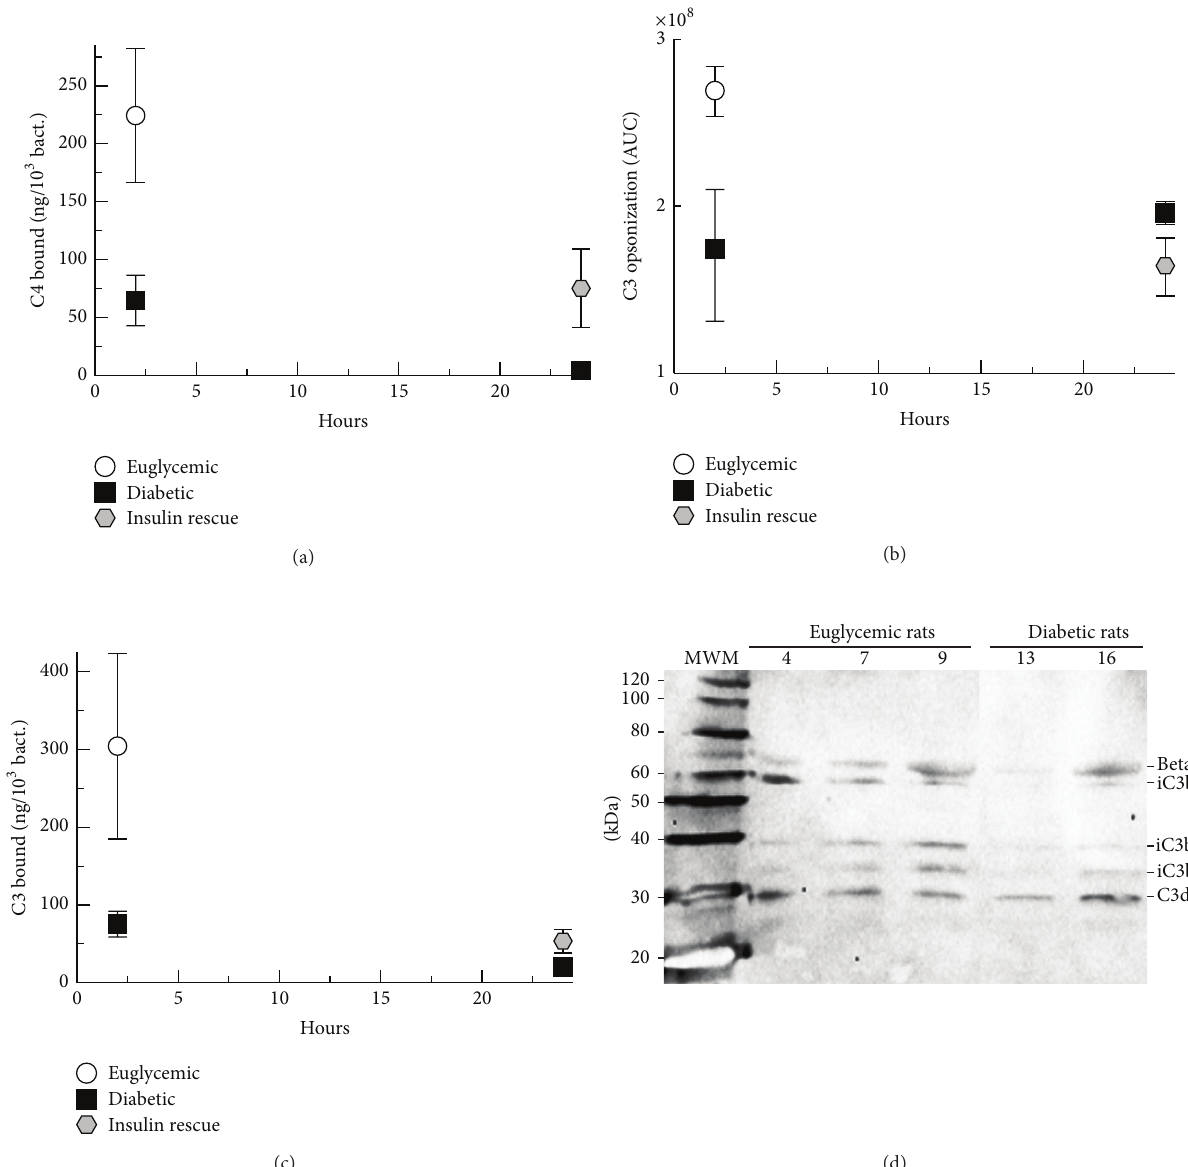
Figure 4: Opsonization of S. aureus recovered from the peritoneum. (a) Washed bacteria were stripped of bound C4-fragments and assayed by ELISA. (b) Washed bacteria were analyzed by flow cytometry after incubation with anti-C3 antibody. Area under the curve was measured for each sample (log scale). (c) Washed bacteria were stripped of bound C3-fragments and assayed by ELISA. Graphed data shows means of results for peritoneal samples from the animals in each treatment group. Error bars denote standard error of the means. (d) Total C3-fragment Western blot of stripped bound C3-fragments from representative samples revealing predominantly iC3b and